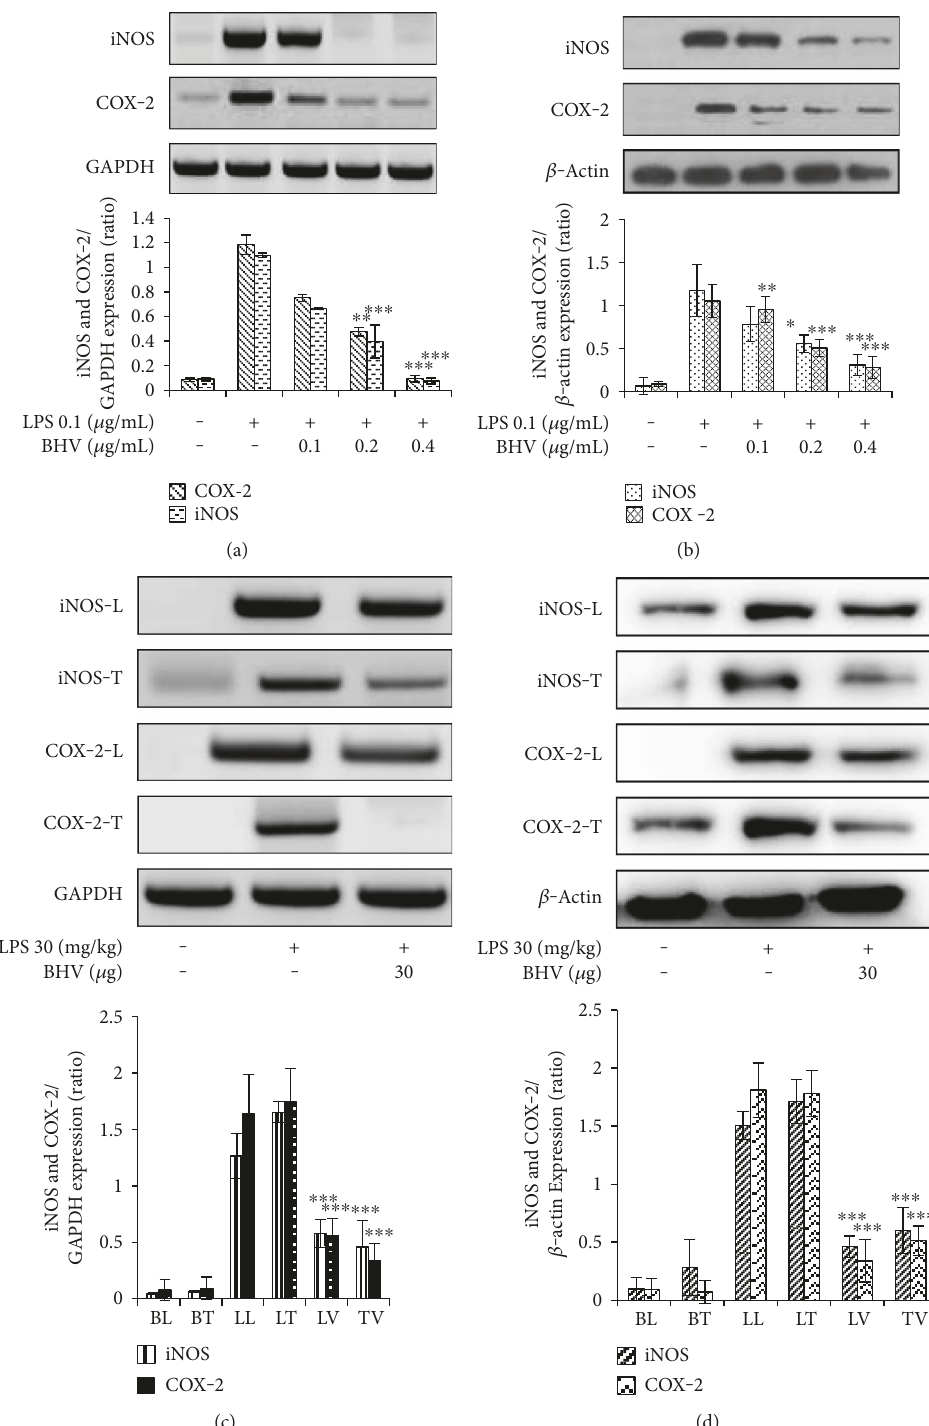
Figure 2: Inhibitory e ff ects of B. hebetor venom on the expression of iNOS and COX-2. For mRNA and protein expressions, RAW 264.7 cells were seeded in 6-well plates and treated with indicated concentrations of BHV (0.1 μ g/mL – 0.4 μ g/mL) for 30 min and then stimulated with LPS (0.1 μ g/mL) for 18hr. Total RNA from cell, lung, and testis tissues and total protein was extracted using their respective kit protocols. PCR product was analyzed on agarose gels with GAPDH as the internal control. Protein quantitation was done by Pro-Measure (iNtRON biotechnology, Daejeon, Korea), and then proteins were run on SDS-PAGE and analyzed by ECL chemiluminisence with β -actin as internal control. PCR and protein expression in RAW 264.7 cells (a-b). PCR and protein expression in lungs and testis tissue (c-d). Western blot and PCR images are representative of 3 independent experiments. Bar values of ∗ p < 0 01 , ∗∗ p < 0 005 , and ∗∗∗ p < 0 001 were considered statistically signi fi cant. BL =basal lung; BT =basal testis; LL=LPS lung; LT=LPS testis; LV =lung venom; TV=testis